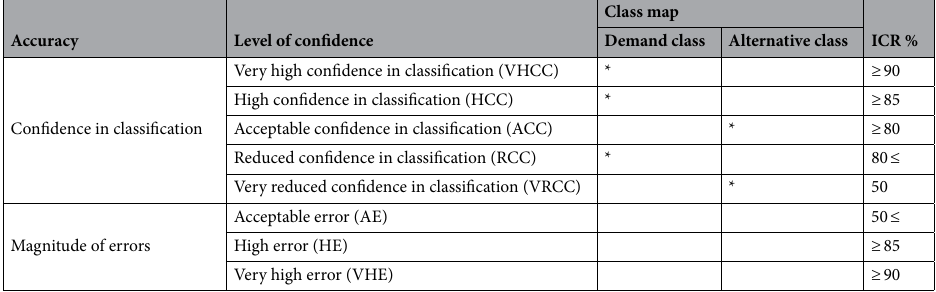
Table 7. The Difference function and its respective default